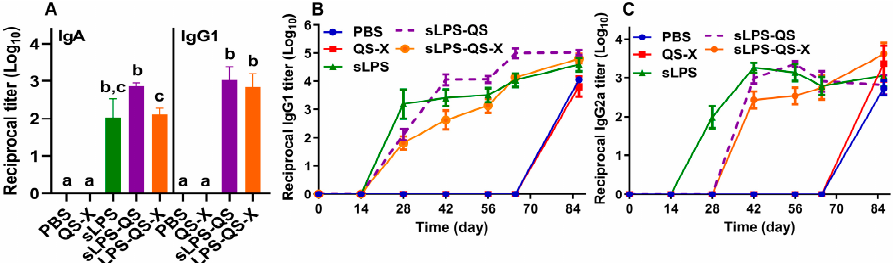
Figure 4. Endpoint titers (Log 10 ) of local and systemic antibody responses in different groups: ( A ) Average (Log 10 ) IgA and IgG1 anti-LPS titers in mice bronchoalveolar lavage. ( B ) Average Log 10 of reciprocal titers of IgG1 anti-LPS titer in peripheral mouse serum. ( C ) Average Log 10 of reciprocal titers of IgG2a anti-LPS titer in peripheral mouse serum. Dates indicate times of sample collection postvaccination. Day 0 and 28 (dates of vaccination), day 56 (day of the challenge), and day 86 (study termination). Data represented as average Log 10 ± SE. A significant increase in the serum IgG1 and IgG2a levels for all tested groups compared to the PBS or the QS-X was found. Data were analyzed by ANOVA and Least Significant Difference (LSD) was used to determine differences between the groups. Different letters indicate that values are significantly different. A p -value of less than 0.05